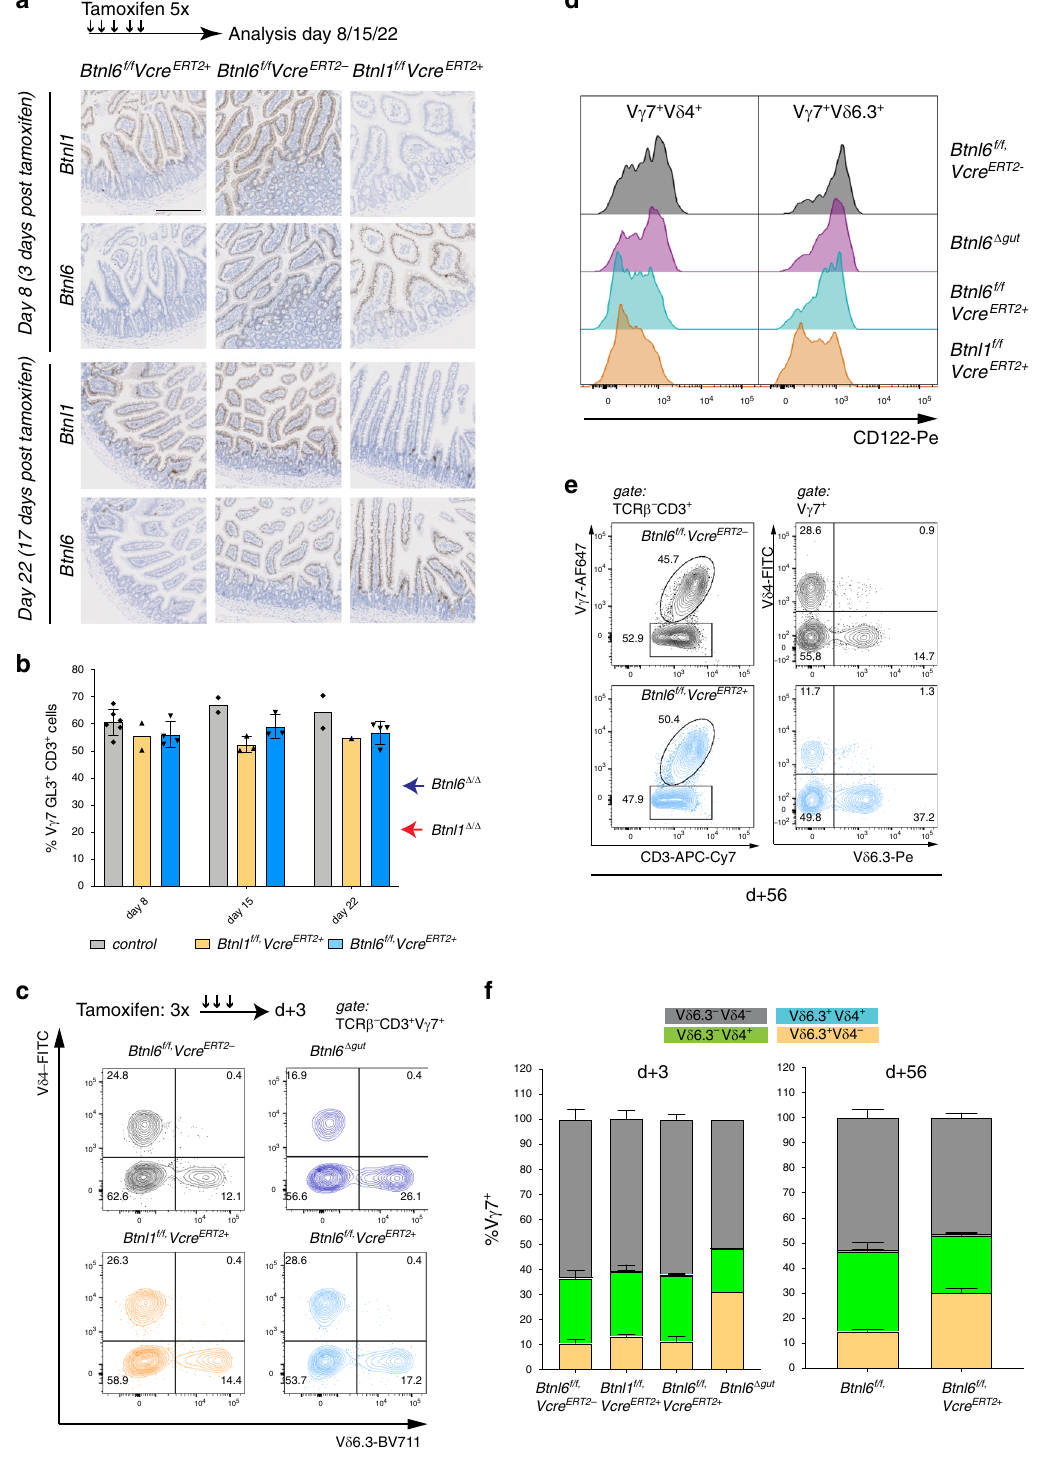
proteins (e.g. Btnl4; BTNL3), when over-expressed, to traf fi c